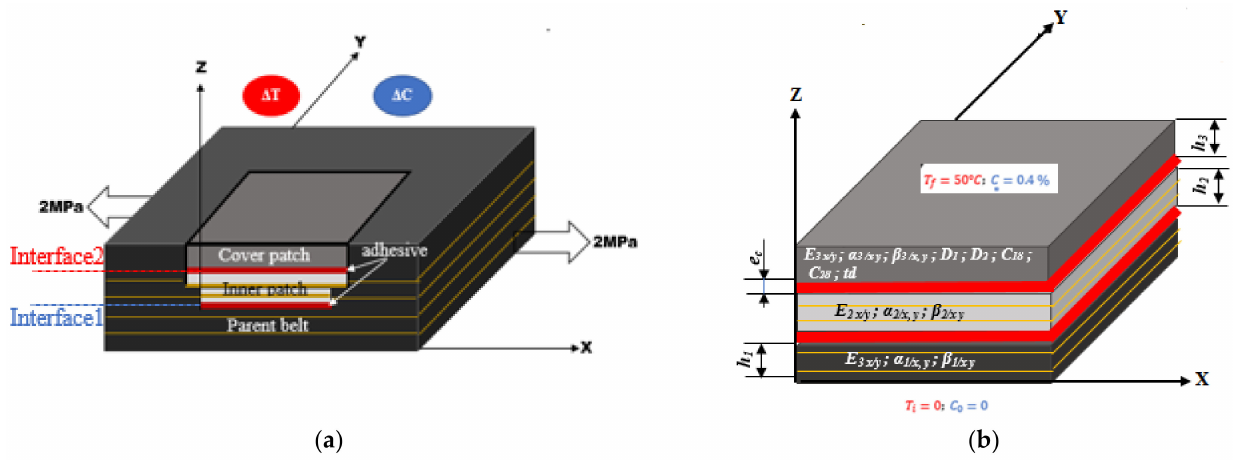
Figure 9. Schematic representation of the belt repaired composite structure under mechanical tension in the presence of the temperature gradient ∆ T and the humidity concentration ∆ C: ( a ) transverse section with two interfaces; ( b ) geometric parameters and material properties needed for the 2D model.